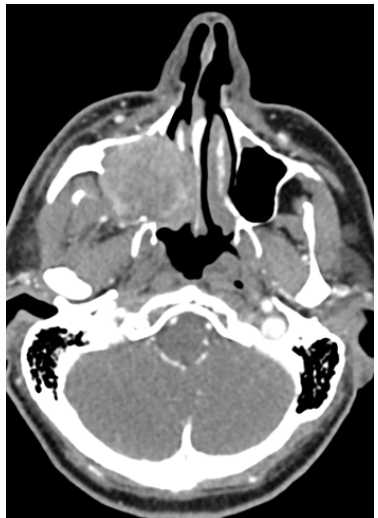
Figure 1. Axial CT imaging demonstrates a solid nonhomogeneous tumour that completely fills the right maxillary sinus, destroying the medial and dorsolateral wall of the sinus and the base of the right orbit. The CT images are published with the permission of the Radiology Department, The Hospital of Č eské Bud ě jovice, Czech Republic.